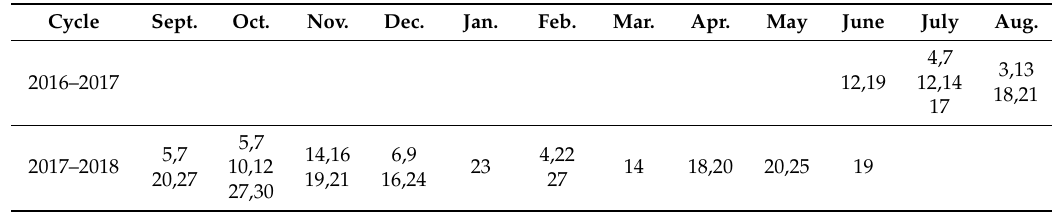
Table 1. Dates of cloud free S2 acquisitions over Camargue.